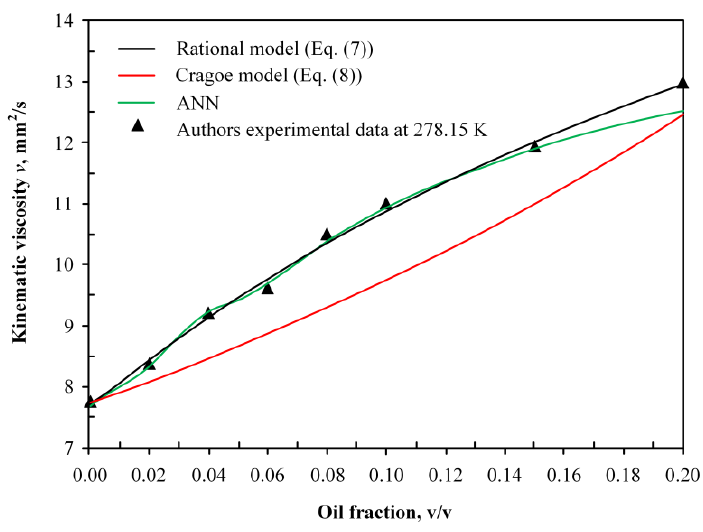
Fig. 7. Variation in kinematic viscosity vs. oil fraction at 278.15